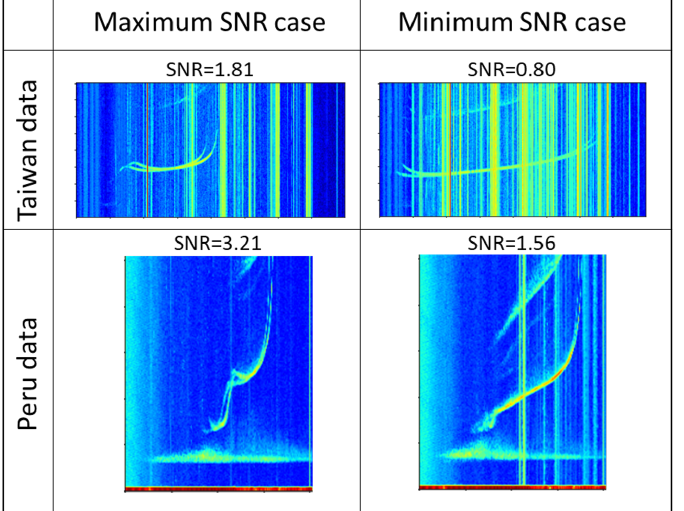
Figure 5. Maximum and minimum SNR cases for Taiwan ( upper panels ) and Peru ( lower panels